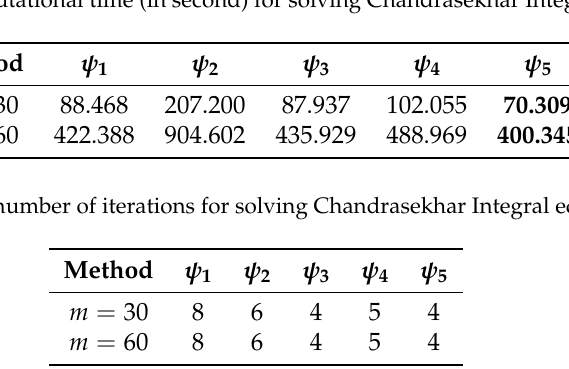
Table 7. The computational time (in second) for solving Chandrasekhar Integral equation.